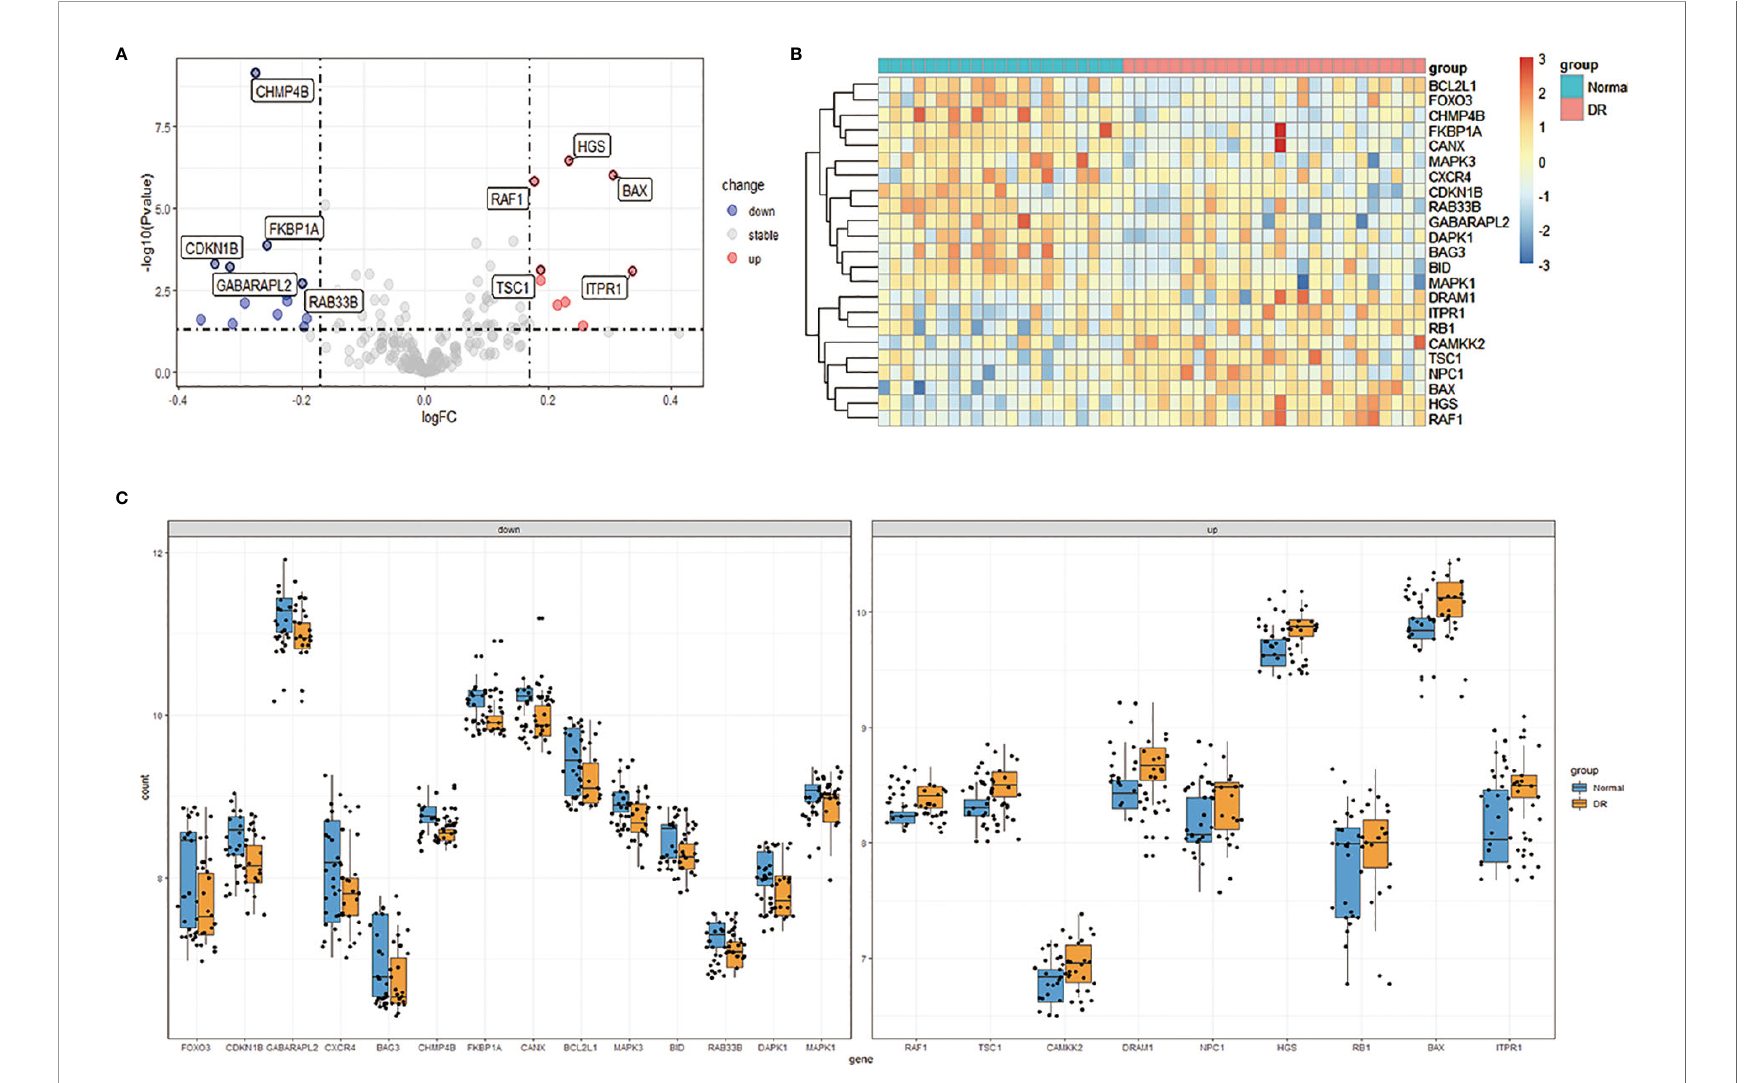
FIGURE 2 | Differentially expressed autophagy-related genes in DR patients (DR group) and non-diabetic individuals (Normal group). (A) , Volcano plot of 232 differentially expressed autophagy-related genes. The red dots in the picture represent signi fi cantly up-regulated genes, blue dots represent signi fi cantly down-regulated genes, black dots represent genes that are not differentially expressed, and the fi ve genes that are most signi fi cantly up-regulated or down-regulated are marked. (B) , The heatmap of 232 differentially expressed autophagy-related genes. Red represents up-regulated genes and blue represents downregulated genes. (C) , The boxplot of 23 differentially expressed autophagy-related genes in DR and normal samples. It includes 9 up-regulated genes and 14 down-regulated genes. DR, diabetic